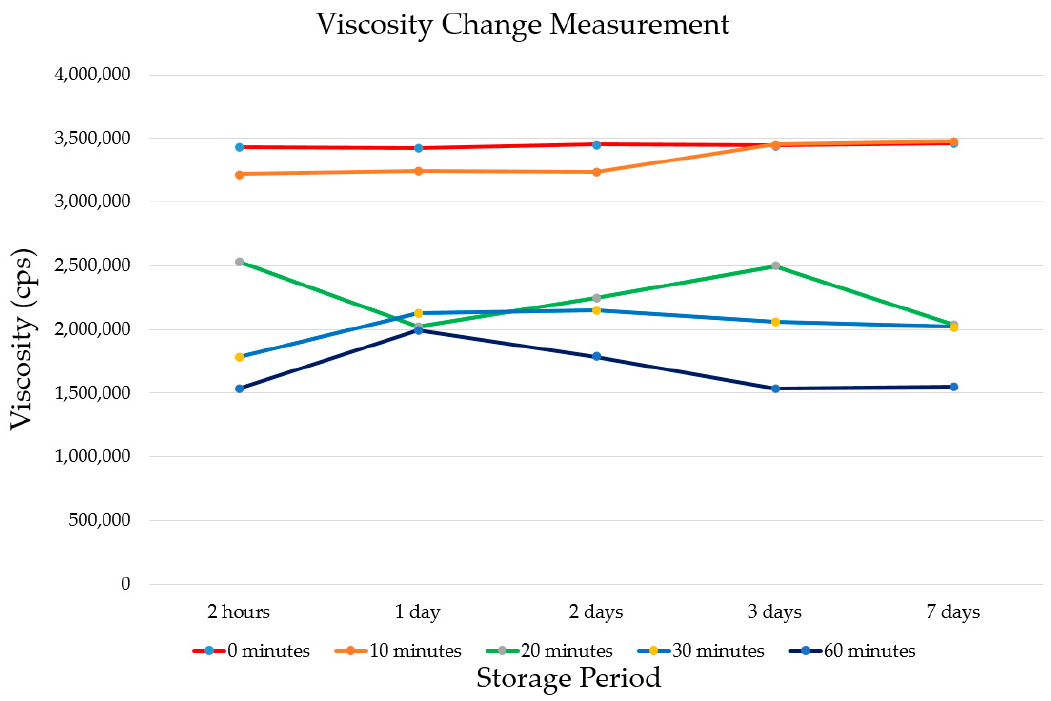
Figure 12. SPRG viscosity change over different storage periods based on respective screw-mixing time.